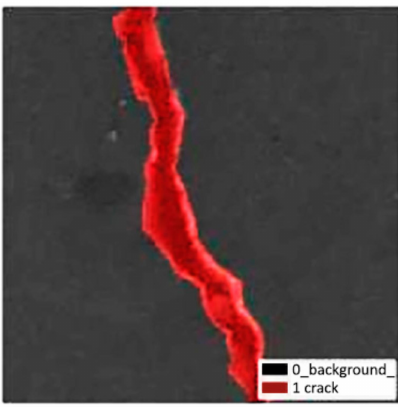
Figure 5. Class visualization